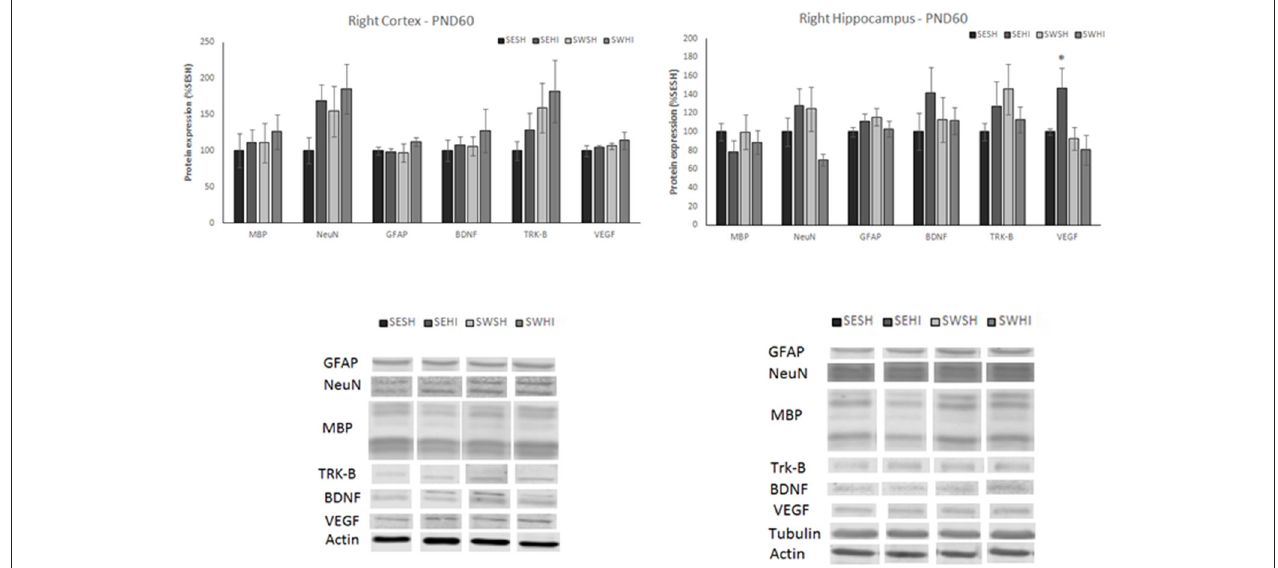
FIGURE 7 | Protein expression of MBP, NeuN, GFAP, BDNF, TRK- β , and VEGF in right cortex (left upper panel) and hippocampus (right upper panel) at PND60. Lower panels: representative immunoblots of cortex (left lower) and hippocampus (right lower). WB results are plotted normalized to the SESH group level expression (100%) (mean ± SEM). Significance testing was determined using one-way ANOVA followed by Duncan’s post-hoc using Actin or β III-tubulin as normalizer. *SESH vs. SEHI. Significance accepted when p < 0.05.